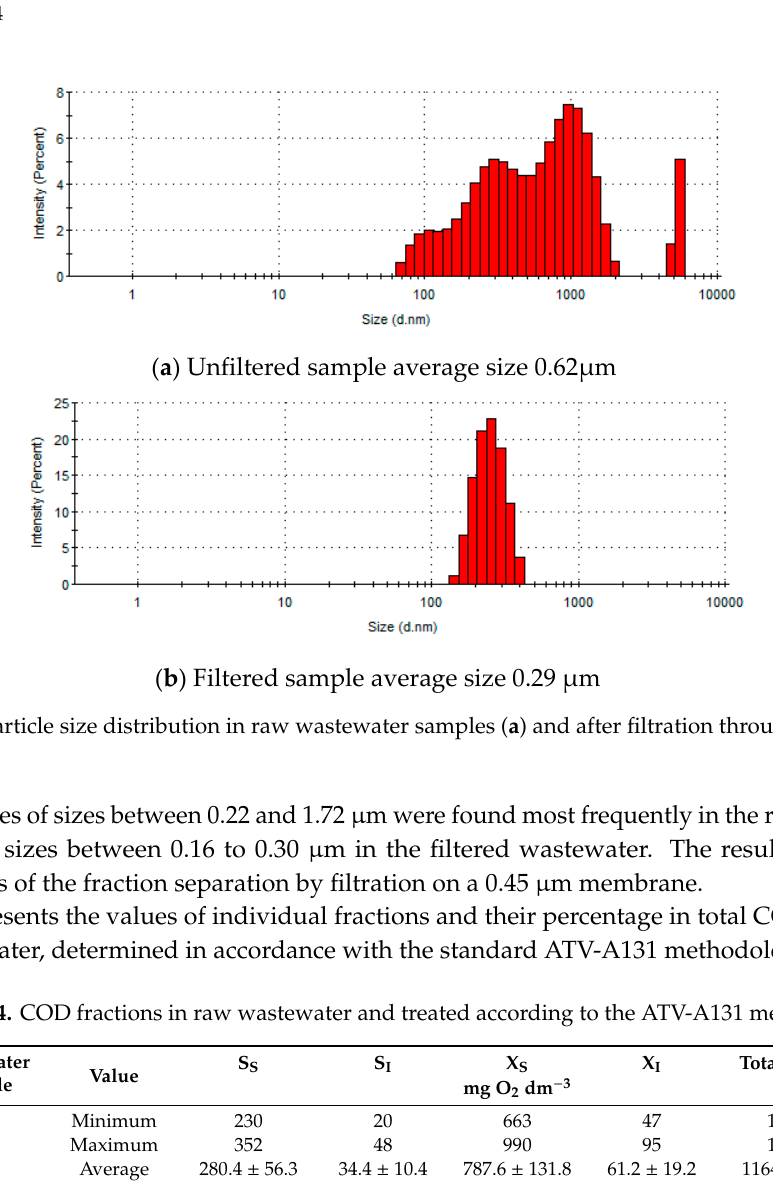
Table 4. COD fractions in raw wastewater and treated according to the ATV-A131 method.